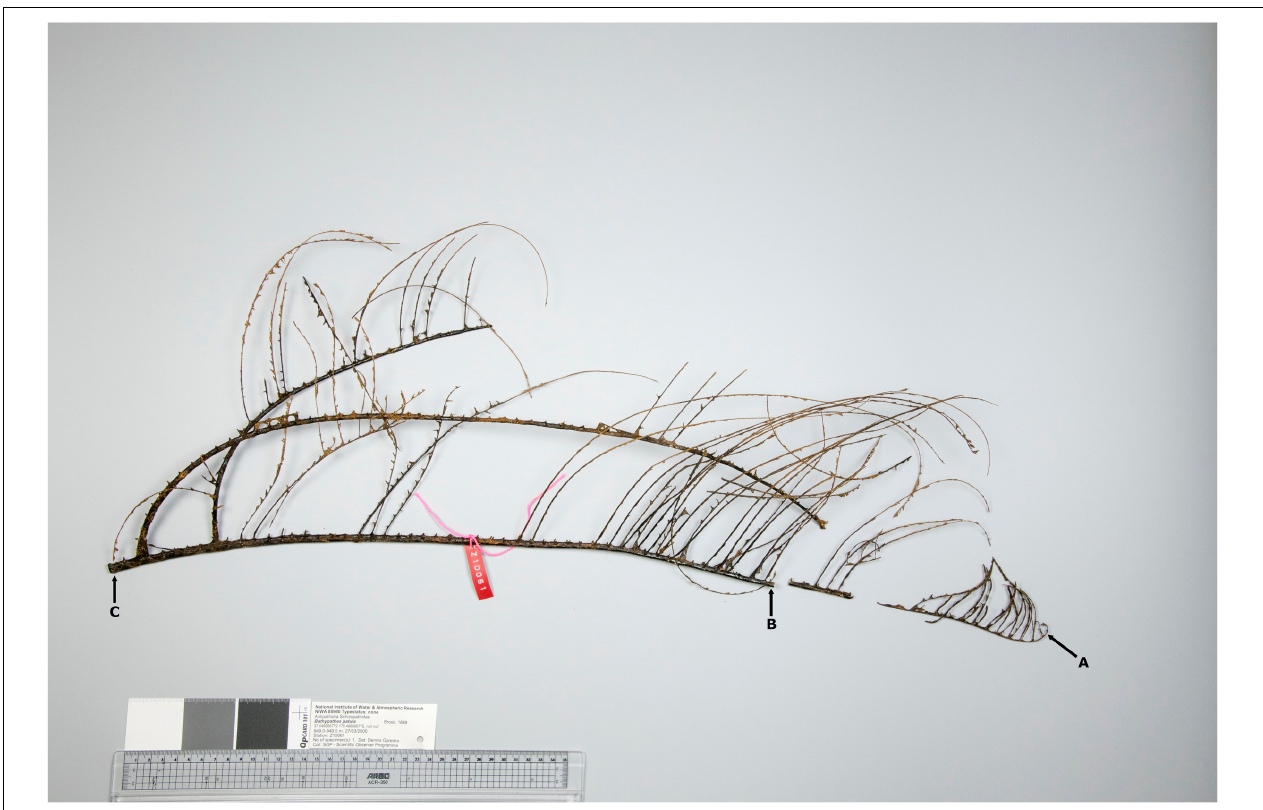
FIGURE 3 | Bathypathes patula NIWA85940. Specimen showing where samples were extracted for analysis. (A) is the growing tip, (C) the basal section, and (B) is an intermediate sample sites as the specimen was broken on collection and unknown lengths of the main branch stem may be missing above this site. Specimen from Bay of Plenty, New Zealand. Scale bar is a 35 cm